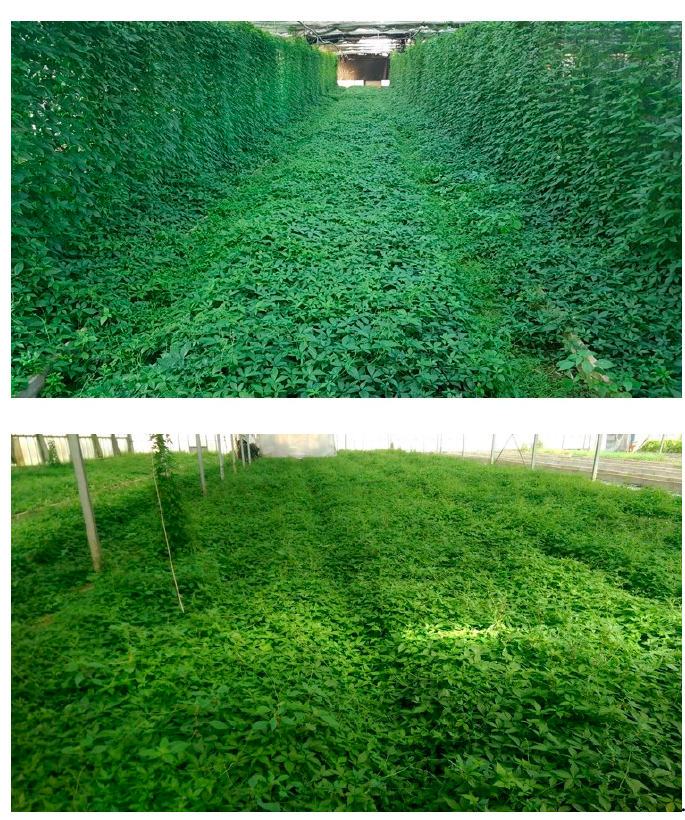
Figure 1. Crops of Gynostemma pentaphyllum (var. Ginpent) from Leno, Brescia,